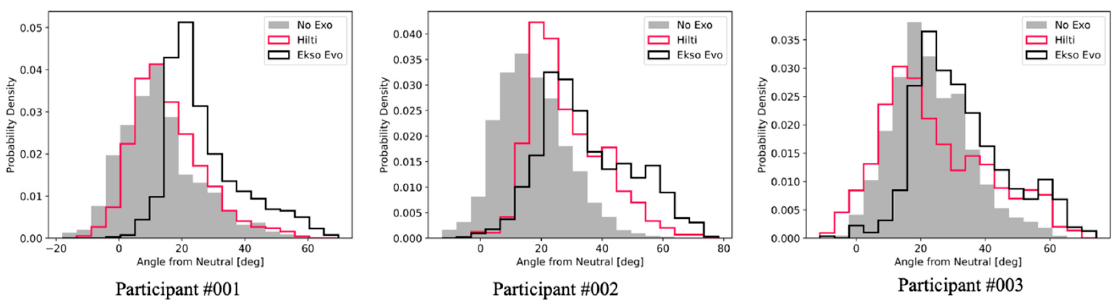
Figure 12. Histograms of abduction/adduction of the left shoulder for block installation.